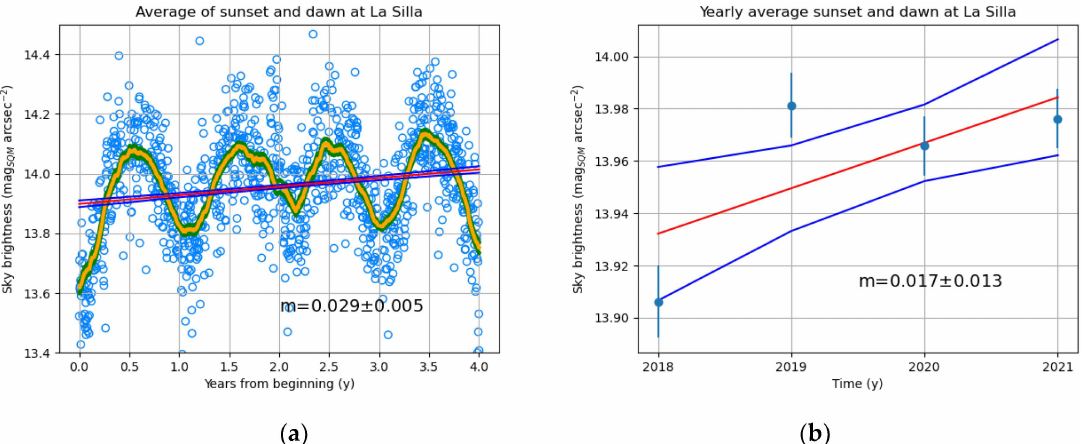
Figure 12. Trends of the sky brightness at zenith at La Silla: average values at sunset and dawn ( a ) with their moving average (yellow curve) and aside the green curves accounting for one standard deviation ( a ) and the annual average values ( b ) when the Sun altitude is around − 6.5 ◦ , the red line is the linear fitting and the blue curves account for the uncertainty on the fitting parameters. Superposed to the daily data and the moving mean is the regression line of the daily average sky brightness. The red line in the section (a) is the linear least squares interpolation of the daily data; it is the simplest approximation of the average long-term trend of the sky brightness at twilight. The blue curves close to the regression red line account for one standard uncertainty in the determination of the line parameters slope and intercept. For each site, the values of the slope in the equation of the lines interpolating the daily data and the yearly average data are presented in Table 2 with their uncertainty (one standard